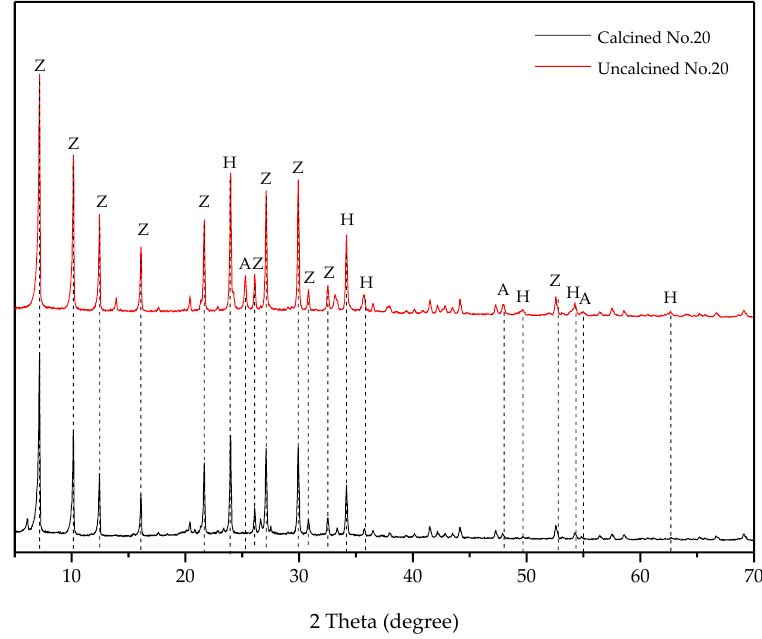
Figure 11. X-ray diffraction (XRD) patterns of the calcined and uncalcined No. 20 samples at 850 °C (Z: 4A zeolite, A: anatase, and H: hematite).